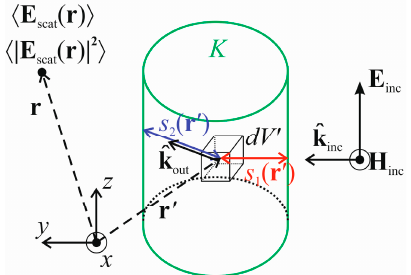
Figure 2. The MST approach. The field inside the canopy’s voxels (cid:1779) (cid:2913)(cid:2925)(cid:2918)(cid:2919)(cid:2924) ((cid:1818)′) depends on the distance through the canopy s 1 ( r (cid:48) ) along ˆk inc and the complex propagation constant K inside the canopy. The coherent (cid:104) E scat ( r ) (cid:105) and incoherent (cid:104)| E scat ( r ) | 2 (cid:105) scattered fields are obtained at r , which is in the ˆk out direction with respect to the canopy’s